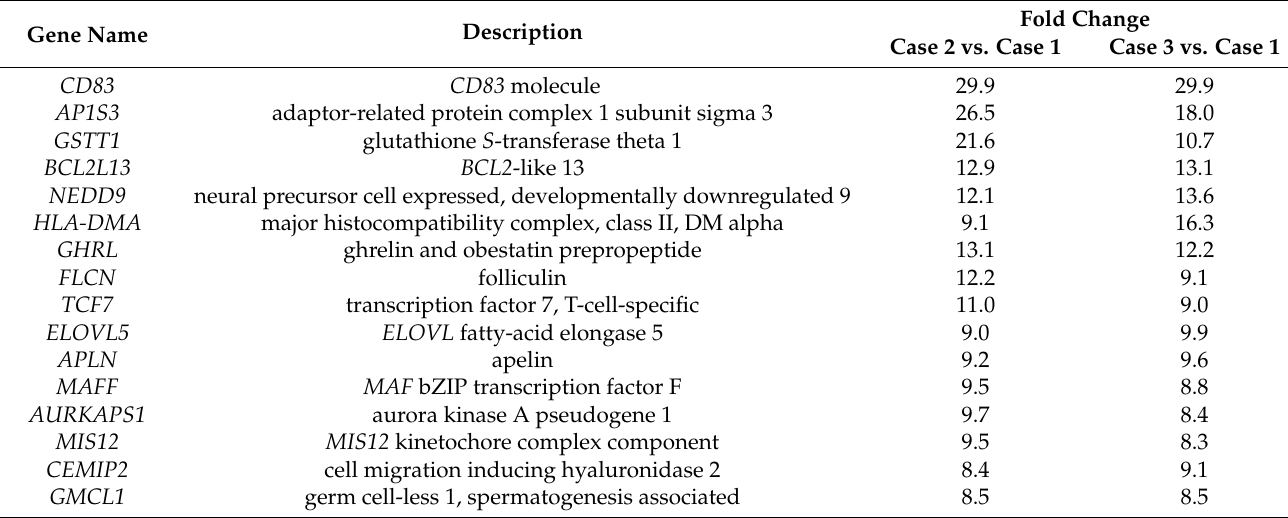
Table 3. Sixteen genes that overlapped and were enriched (>8-fold) in the tunica media of the closing DA tissues (Cases 2 and 3) compared to that of the patent DA tissue (Case